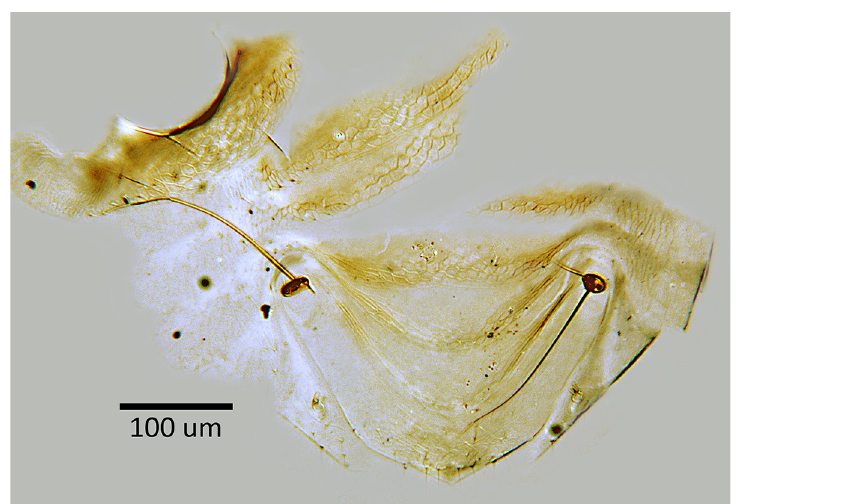
Fig 6. M . macadamiae female holotype, metasomal terga.